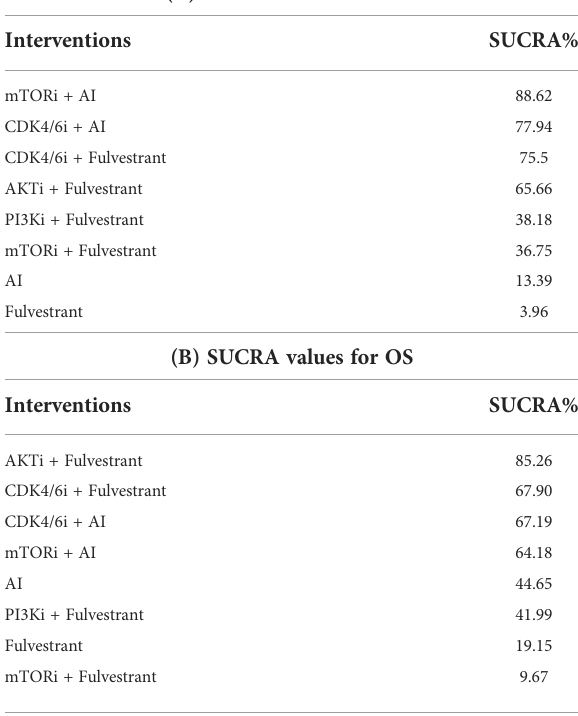
TABLE 4 SUCRA values of each combination regimen for PFS (A) and OS (B). (A) SUCRA values for